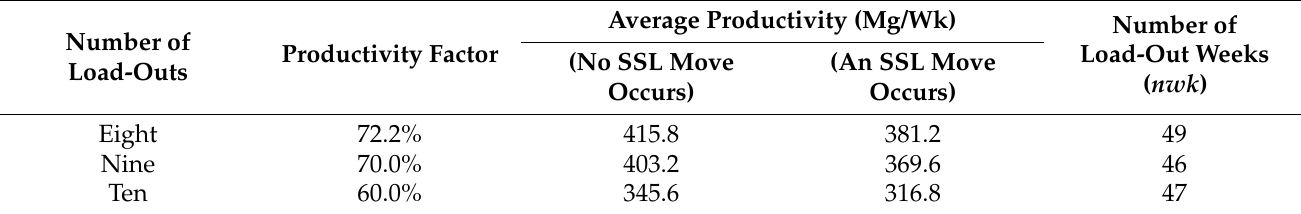
Table 1. Assumed average productivity parameters for the three load-out